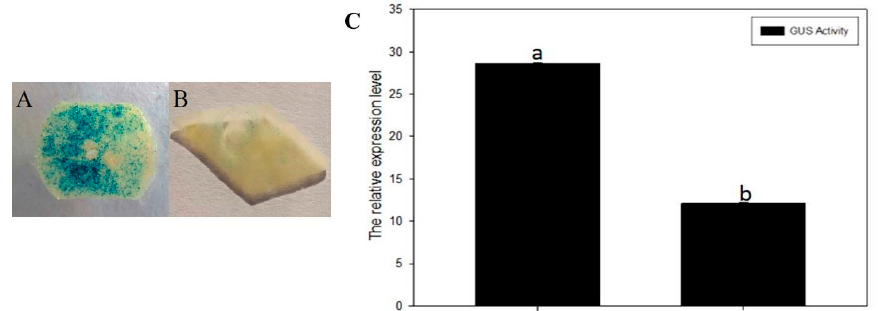
Figure 10. Tobacco transient expression to investigate the regulation of the NtFLS promoter by NtMYB3.